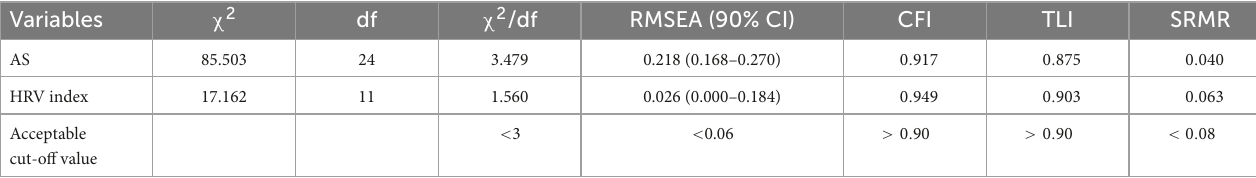
TABLE 4 Confirmatory factory analysis of self-rating anxiety score and heart rate variability (HRV) index in virtual reality-based assessment in panic disorder (VRA-PD).